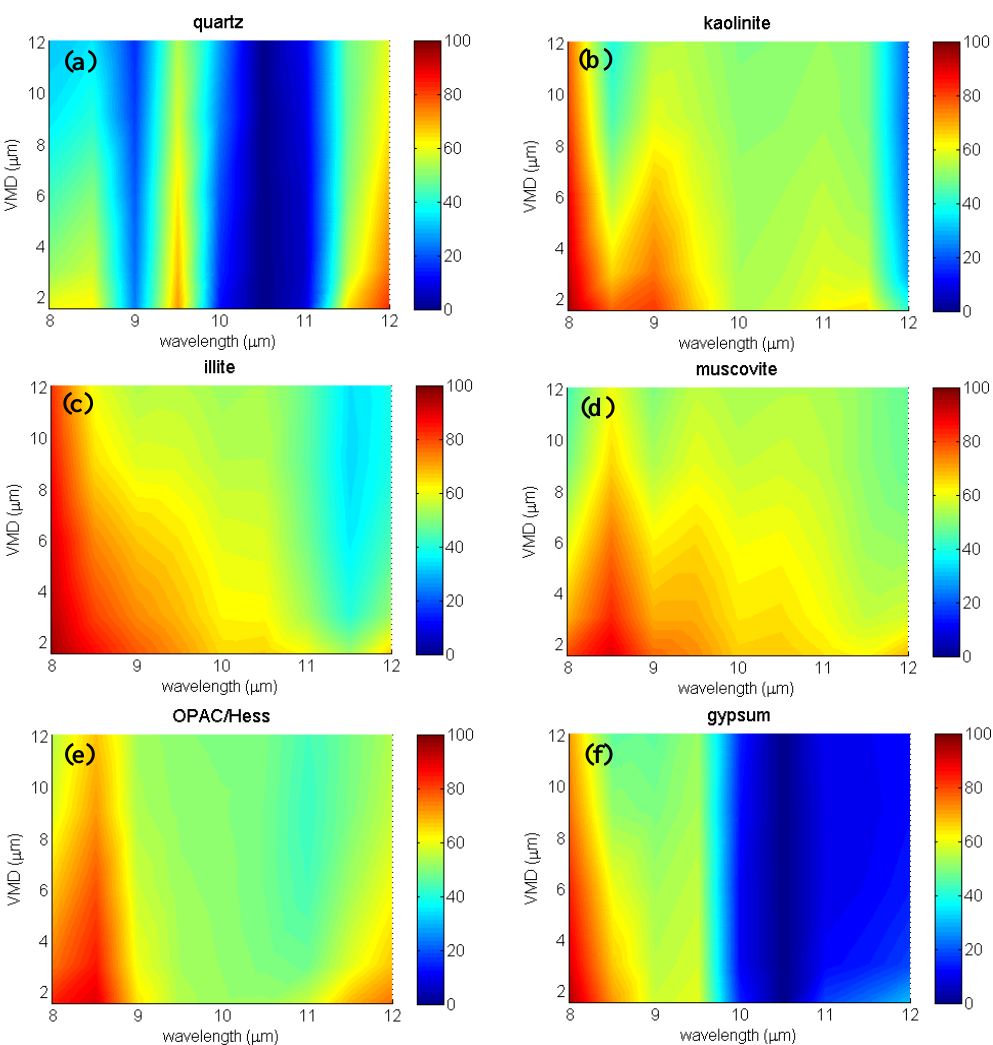
Fig. 4. MAE as a percentage of MEE for common dust minerals across the thermal IR including (a) quartz (rectangle), (b) kaolinite (plate), (c) illite (plate), (d) muscovite (grain), (e) Hess/OPAC (plate) and (f) gypsum (rectangle). The vertical and horizontal axes are the particle VMD and wavelength, respectively. The color bar denotes the percentage of particle extinction due to absorption. Note the unique positions and shapes in the absorption features for each mineral composition. See text for details.